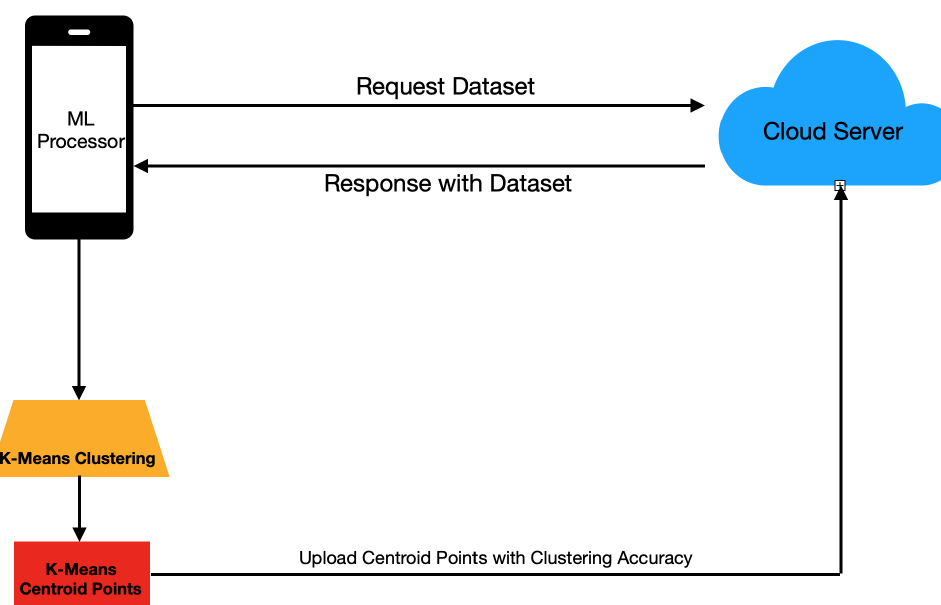
Figure 5. Proposed solution